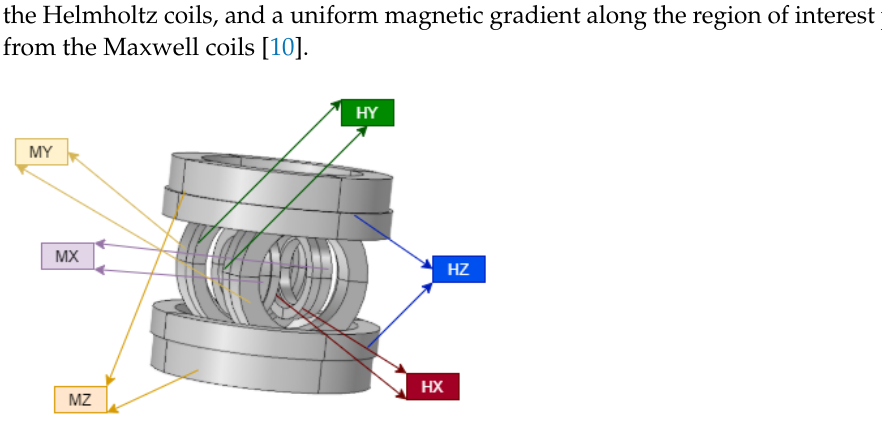
Figure 5. EMA system consisting of three pairs of Helmholtz coils and three pairs of Maxwell